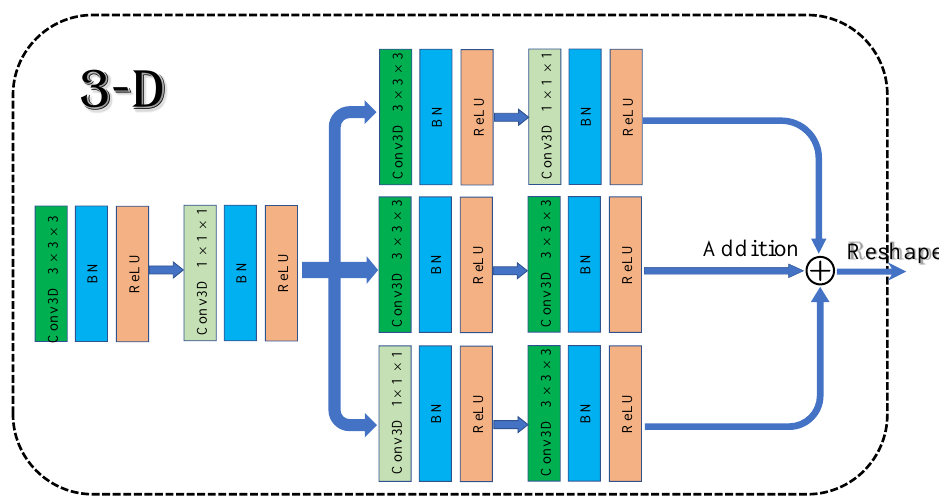
Figure 1. The architecture of 3D multibranch fusion module.